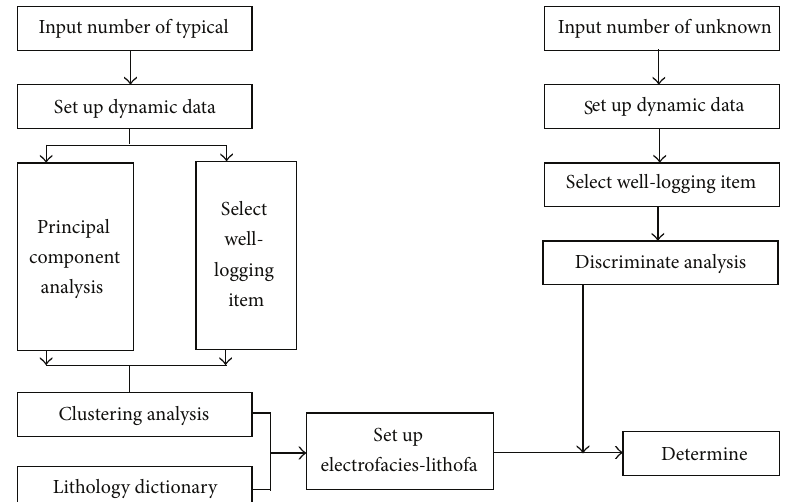
Figure 5: Flow diagram of electrofacies analysis.